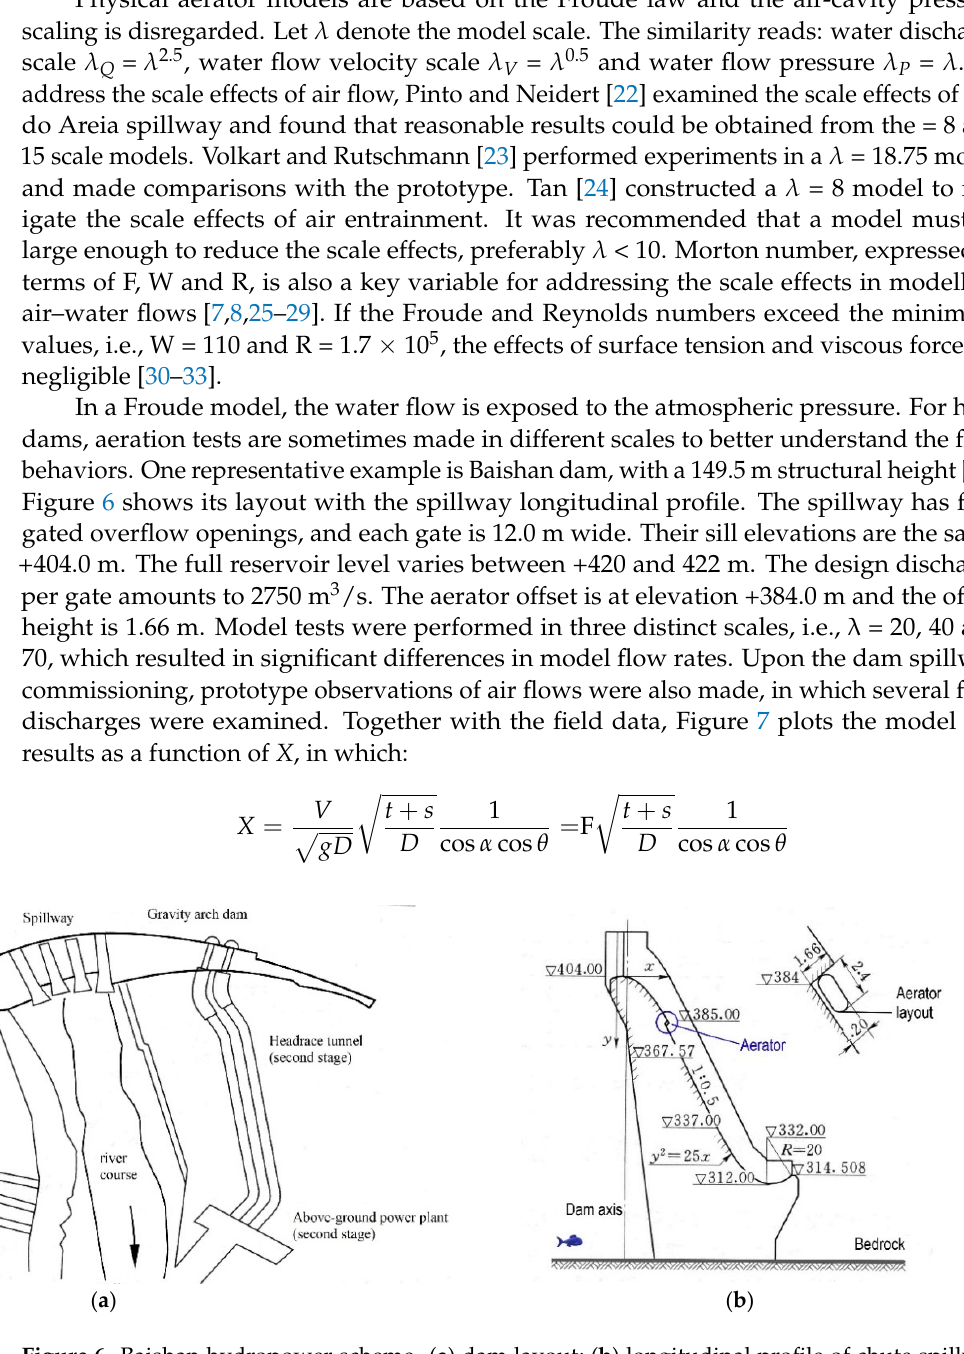
Figure 7. Baishan spillway aerator, β results from model tests of three scales ( λ = 20, 40, 70) and prototype measurements (adapted from [12]). Another typical example is the aerators in the Jinping ‐ I flood tunnel on Yalong River [15]. The 1407 m long tunnel, designed for a 3200 m 3 /s flood discharge, is built with a horseshoe ‐ shaped cross ‐ section and four aerators at varying intervals (Figure 2). Each of the three upstream aerators is composed of both an offset and a deflector. All the offsets are 1.5 m high, and the deflectors are 0.5, 0.4 and 0.2 m high, respectively. The fourth one is shaped in a three ‐ dimensional configuration, featuring sudden ‐ narrowed sidewalls and a convex deflector. From up ‐ to downstream, their protection lengths are 81.0, 87.8, 128.6, and 115.6 m, respectively. An air shaft connects each aerator to the atmosphere. The Froude model tests were made in scale λ = 30. The air flow from the model tests was converted to the prototype by the same scale as the water flow (i.e., upscaled by λ 2.5 ). After the competition, efforts were made to perform prototype measurements of air flow rate, cavity pressure, air concentration, etc., which provided valuable information to the engineering profession. A comparison is made between the prototype and model results of air demand at the design discharge Q = 3200 m 3 /s. The results show that, at aerators No.